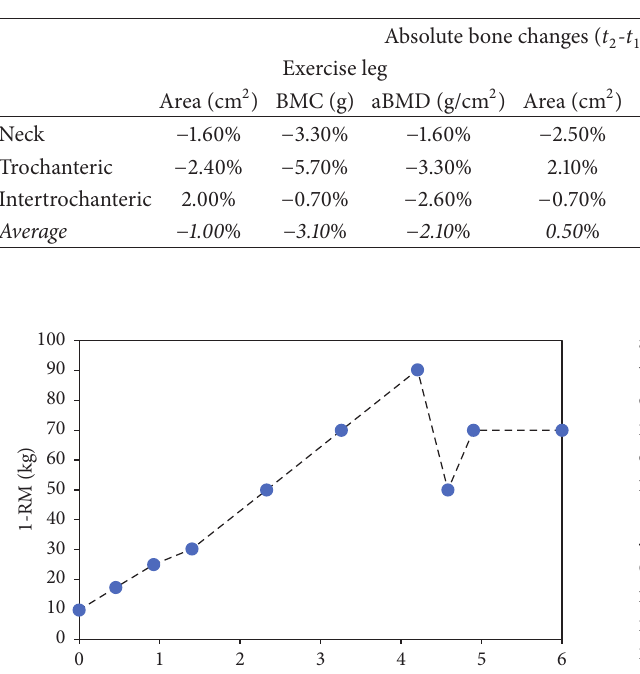
Table 1: Absolute and adjusted bone changes in the proximal femur. Values represent the percentage change of area, Bone Mineral Content (BMC) and areal Bone Mineral Density (aBMD) at six-month training ( t 2 ) with respect to the same values measured at training commencement ( t 1 ).